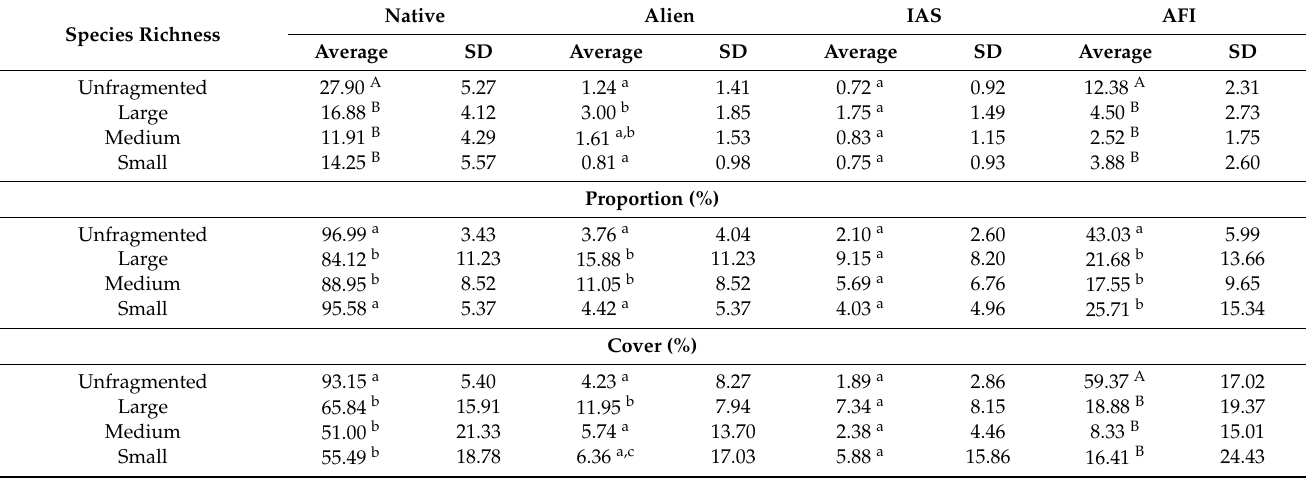
Table 3. Species richness, proportion, and cover of native, alien, invasive alien, and ancient forest indicator plants in the unfragmented forest, large, medium, and small forest fragments. Average values with standard deviation are given. Different uppercase and lowercase letters represent significant differences at p < 0.05 for Tukey HSD or Mann–Whitney pairwise test,